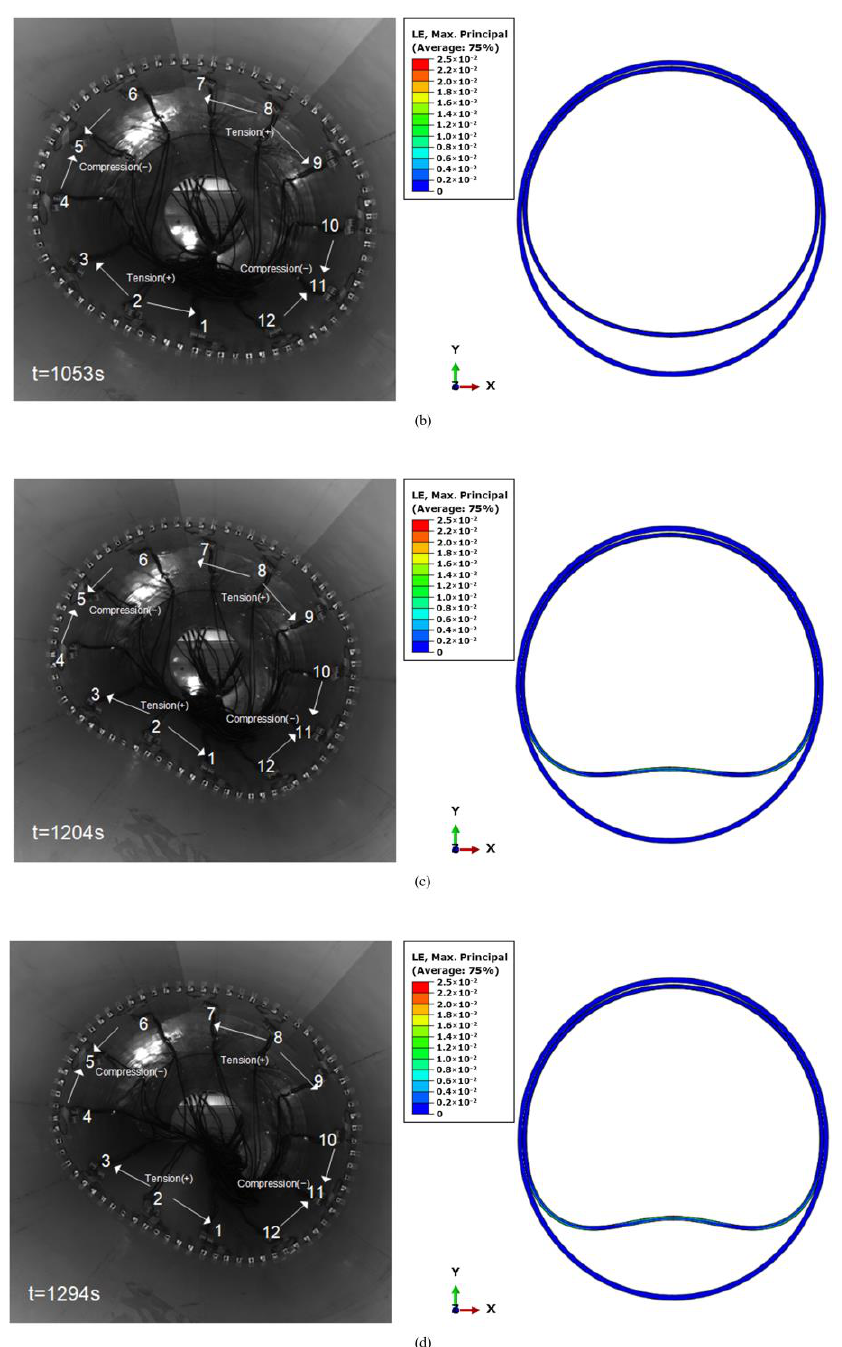
Figure 6. Comparing the deformation status of buckling liners at ( a ) point A; ( b ) point B; ( c ) point C; ( d ) point D marked in Figure 5.